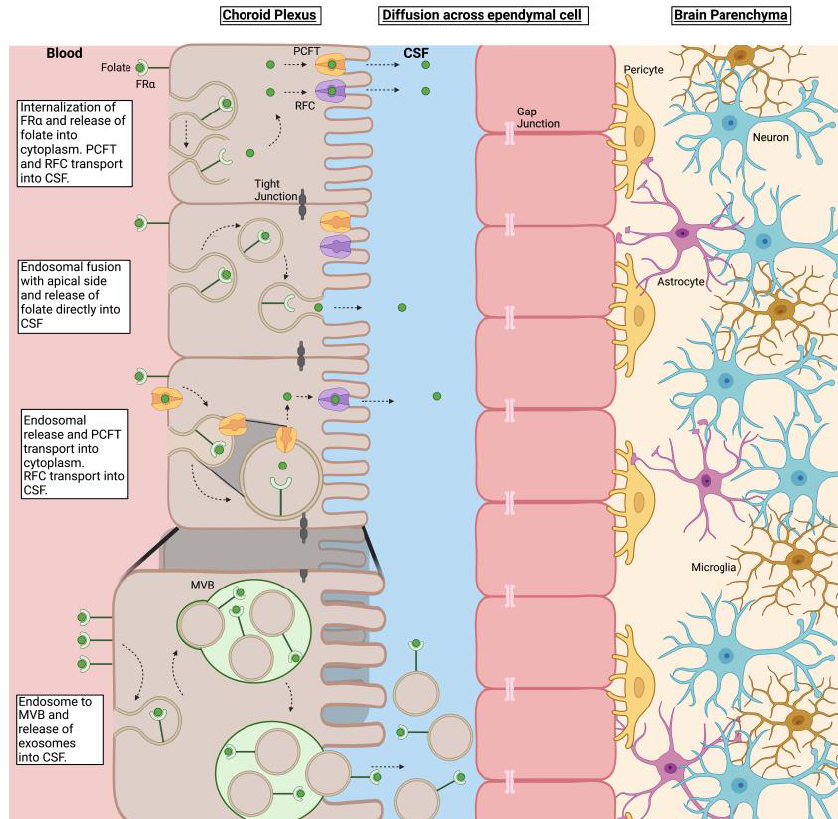
Figure 6. Potential mechanism of folate uptake into the choroid plexus epithelium and transport into the CSF. This active transport results in a 3–4-fold concentration of folate in the CSF compared to plasma (Abbreviations: cerebral spinal fluid; CSF, folate receptor alpha; FR α , multivesicular body; MVB, proton-coupled folate transporter; PCFT, reduced folate carrier; RFC).